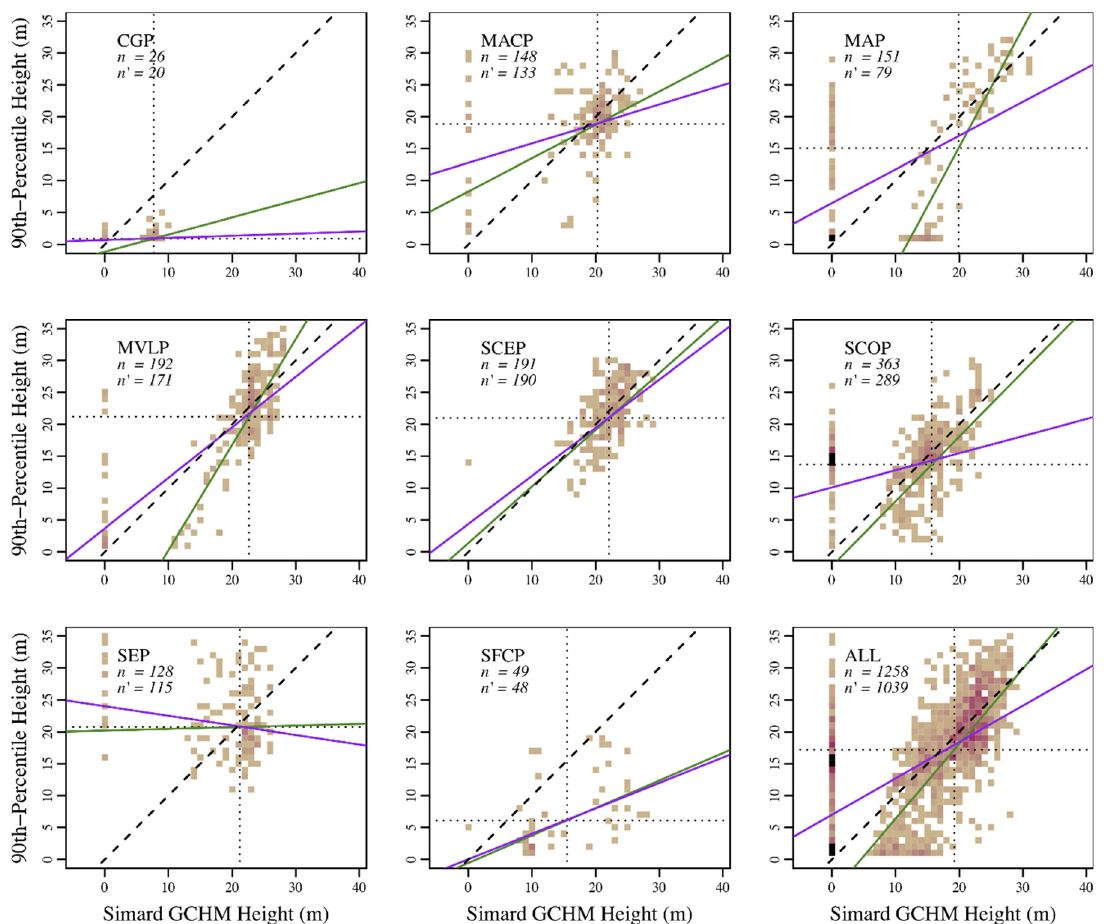
Figure 6. Scatterplots and fitted models for each ecoregion (except for EP) and for all regions combined; SIM GCHM-zeros were included/excluded for the purple/green fits (with sizes of n and n ′, respectively). The associated statistics are provided in Table 4. Dotted lines indicate the respective means and dashed lines indicate the 0–1 lines. The color represents the number of data points, with tan as 1, maroon up to 16, and black more than 16. The maximum was 44 points at SIM GCHM = 0 and airborne lidar 90th percentile heights less than 1 m, for all data combined.